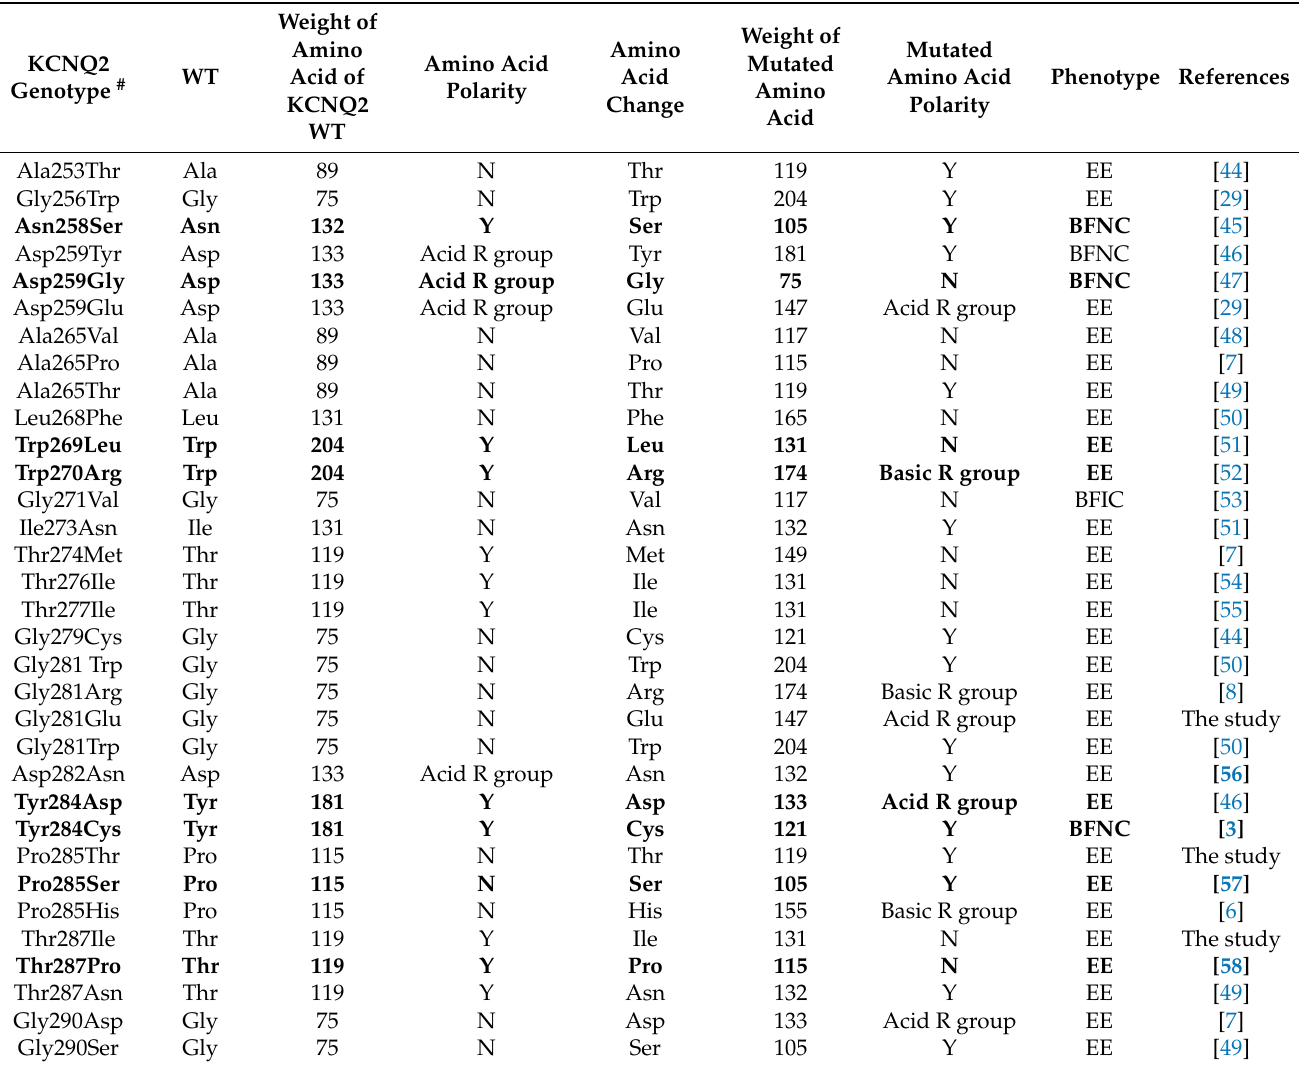
Table 3. Among 35 mutations in the selectivity filter domain, changes in amino acid weight between the WT and the mutations are